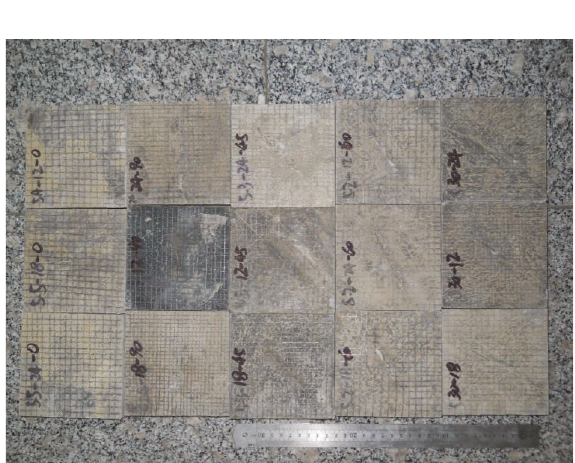
Figure 3: Test condition